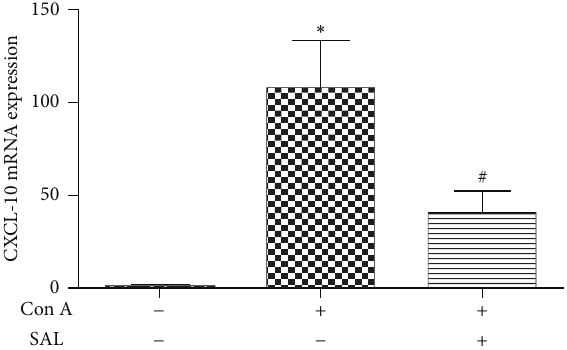
Figure 7: Intrahepatic mRNA expression of CXCL-10. Samples were collected 12h after Con A administration. Salidroside alleviated intrahepatic mRNA expression of CXCL-10. The data output is expressed as a fold-change of expression levels. Level of each type of mRNA from control group was normalized to a value of 1 ∗ 𝑃 < 0.01 versus control group, # 𝑃 < 0.01 versus Con A group.